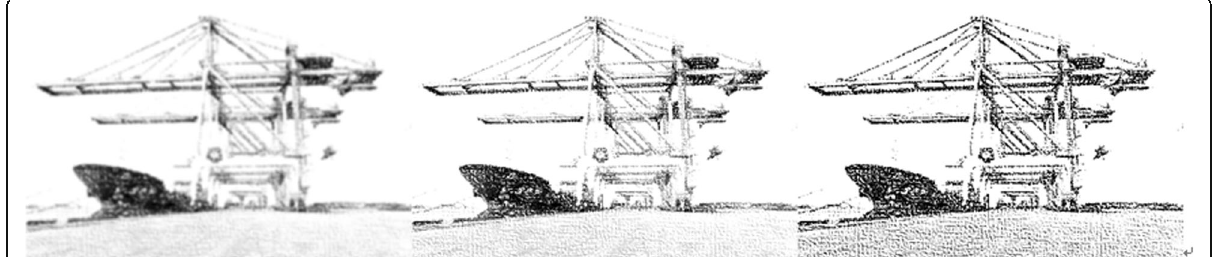
Fig. 3 Filtering results with 10% salt and pepper noise. a The effect of adding noise to the original image. b Effect after Gaussian filter processing. c Results after extreme value median filter